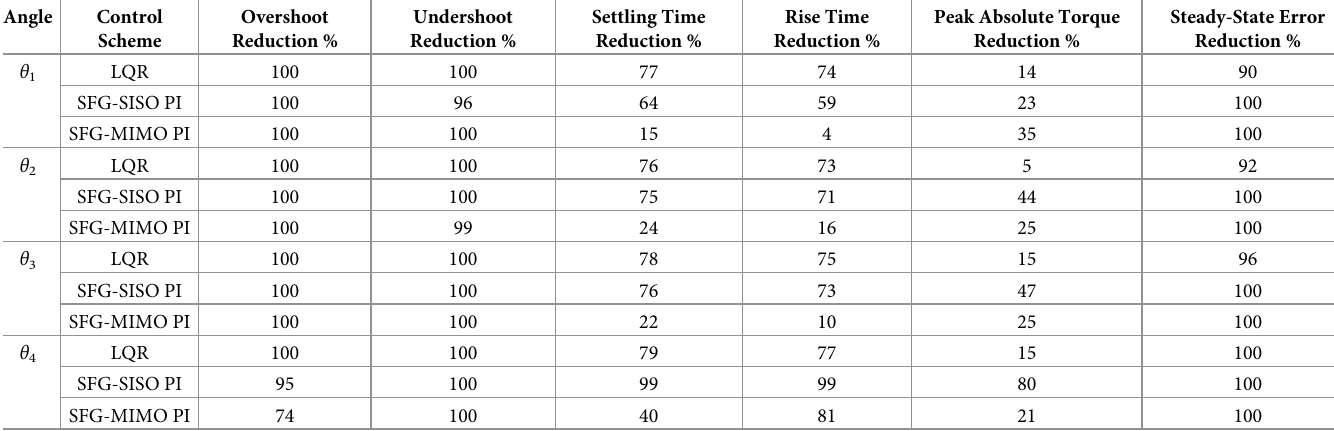
Table 6. Comparison of results in terms of percentage reduction.